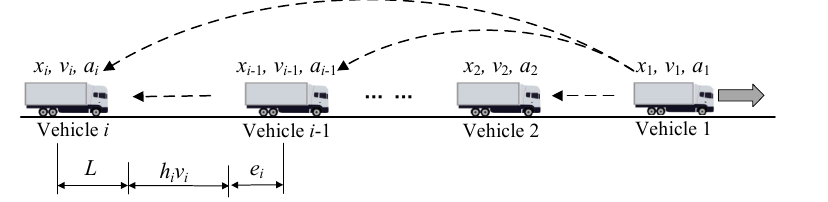
Figure 1. PLF topology structure diagram.